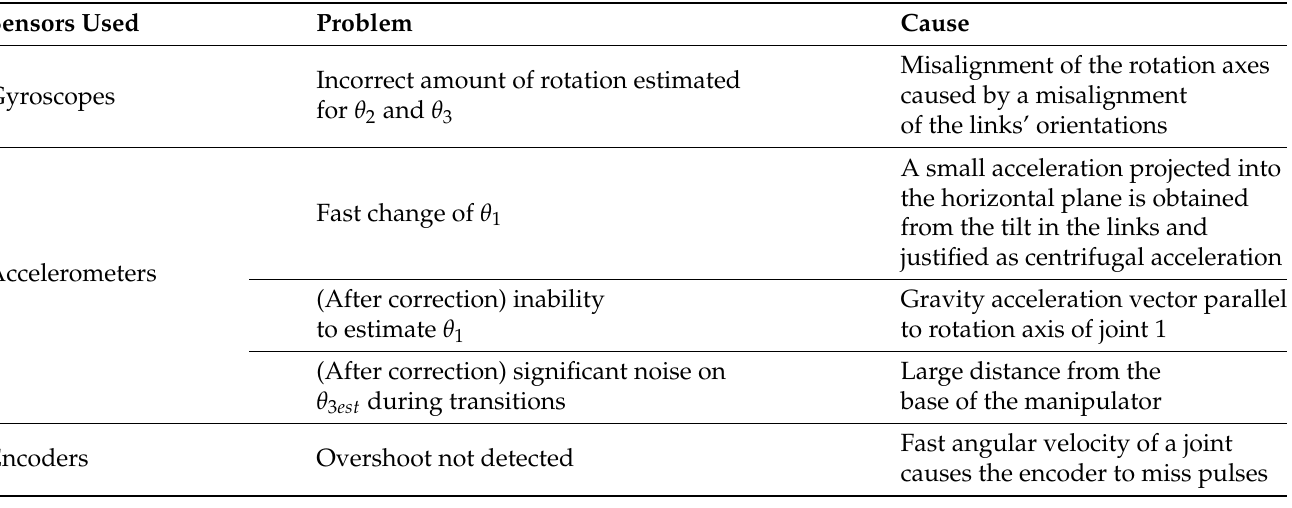
Table 6. Summary of the errors of the joint model using individual sensors.